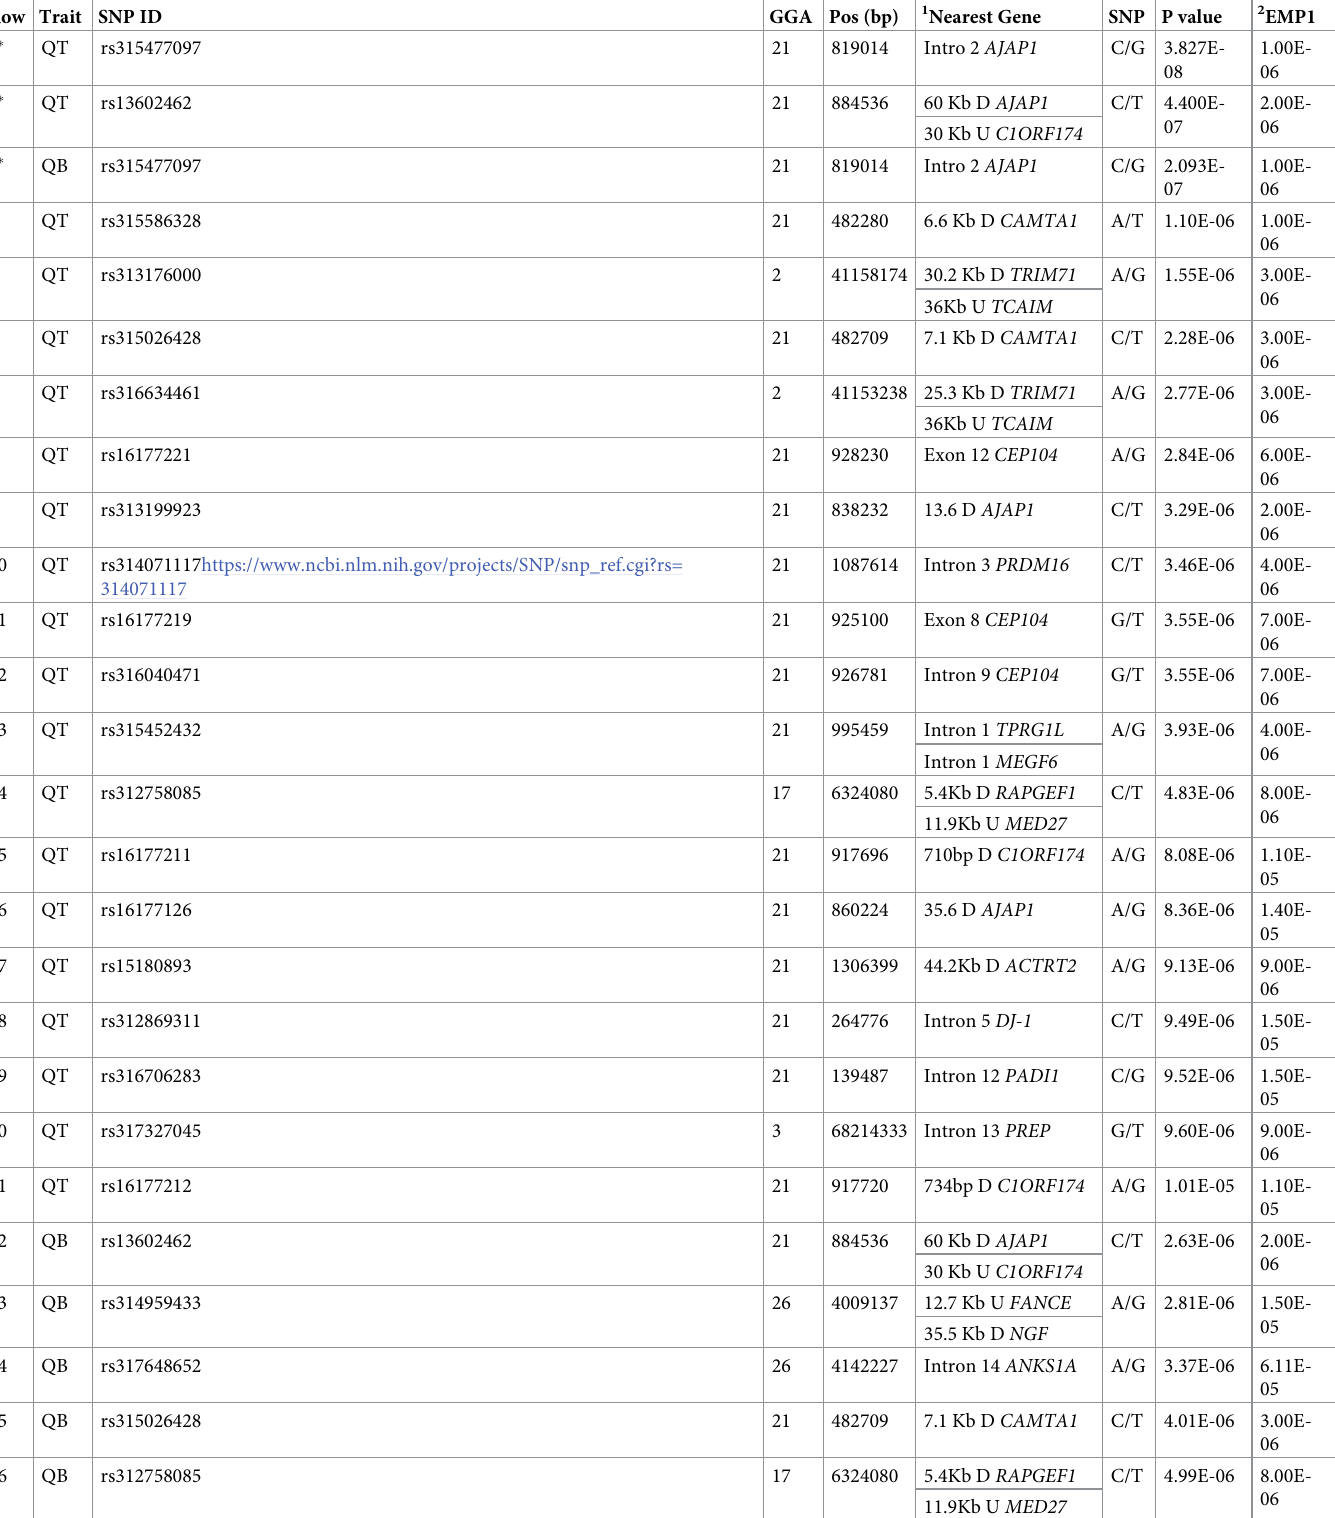
Table 2. Associated SNPs with genome-wise significance and suggestive association (chromosome-wise significance) for eggshell color traits. Row Trait SNP